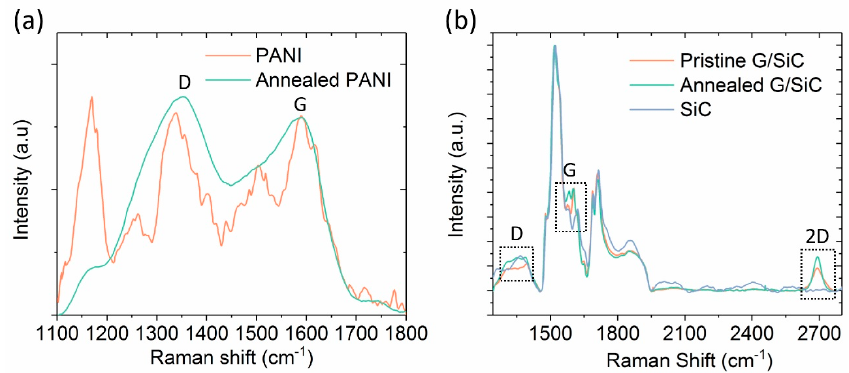
Figure 4. Raman spectroscopy before and after annealing ( a ) Raman spectroscopy on a bundle of PANI nanofibers before and after 800 ° C annealing. After annealing, the complex peaks in PANI nanofibers turned to two broad peaks marked by D and G bands. The intensity of PANI is normalized with respect to the maximum value of D band in annealed PANI nanofibers; ( b ) Raman spectroscopy of the pristine graphene, annealed graphene and SiC. Dotted boxes indicate the vicinity of D, G, and 2D peaks. The intensity is normalized by the highest peak of Raman spectra measured on the SiC substrate.